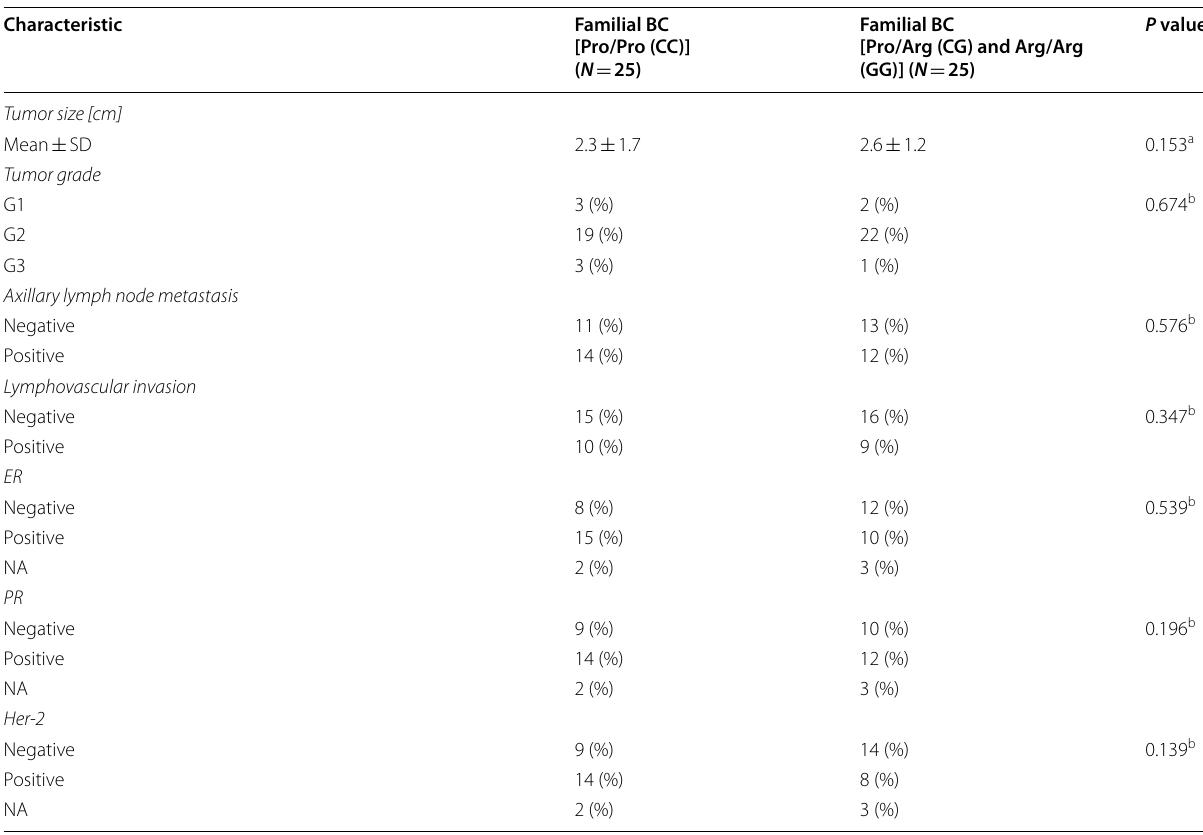
Table 4 Clinical and pathological characterization of familial BC patients with prevalence of TP53 rs1042522 genotypes carrying the high-risk allele [Pro/Arg (CG) and Arg/Arg